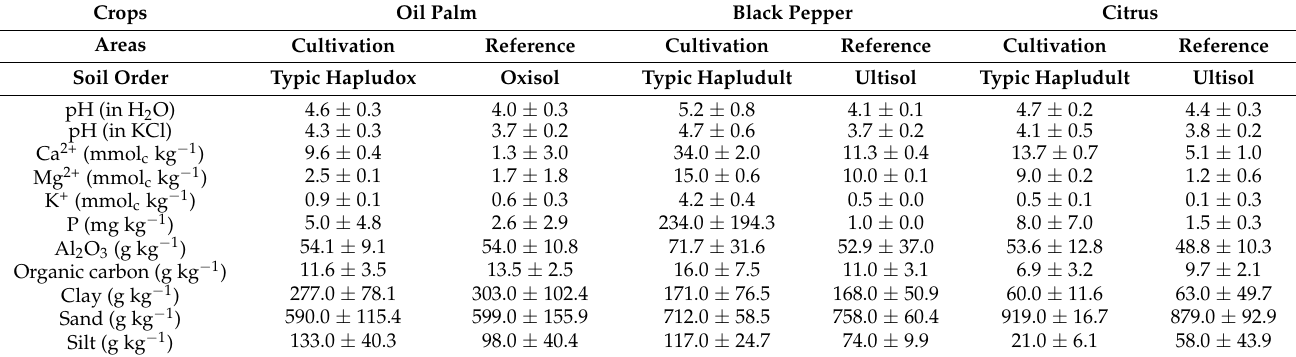
Table 1. Classification, chemical attributes and granulometry of the soils studied (number of samples = 3). Crops Oil Palm Black Pepper Citrus Areas Cultivation